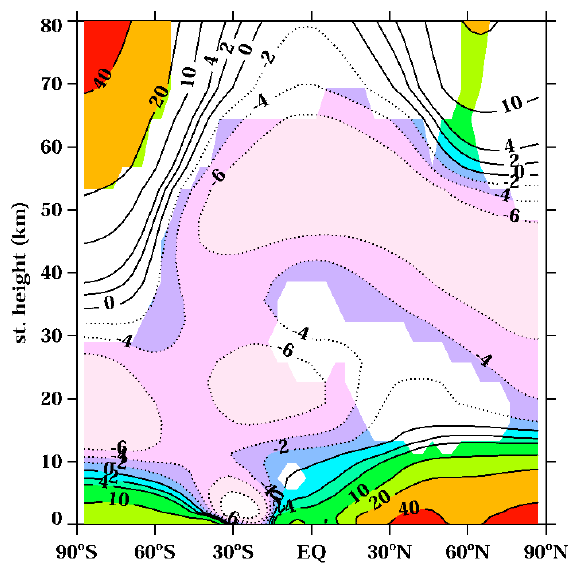
Figure 3. The annual and zonal mean NO y linear trend (%/31 years) during the 1910 to 1940 period for the ALL experiment. The area where the trend is significant at the 90% or better level is marked by color shading.